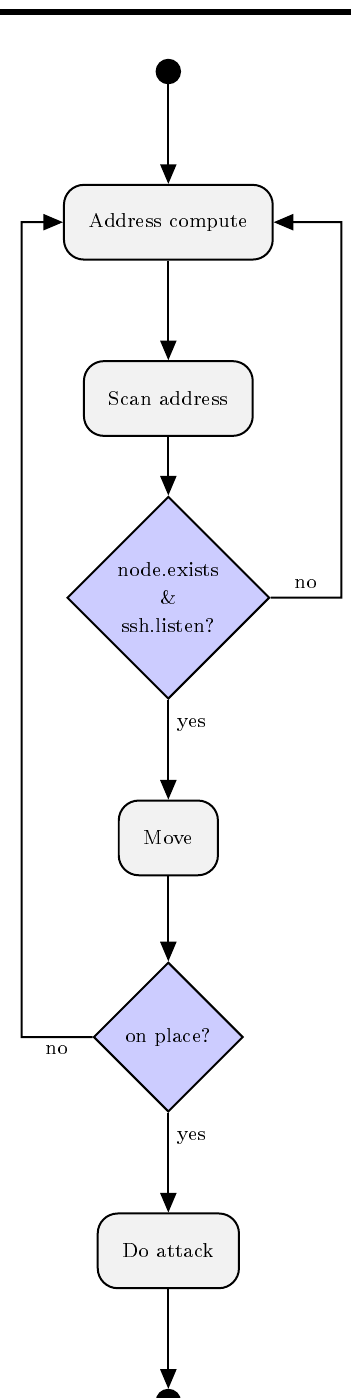
Fig. 5: Describing the state of